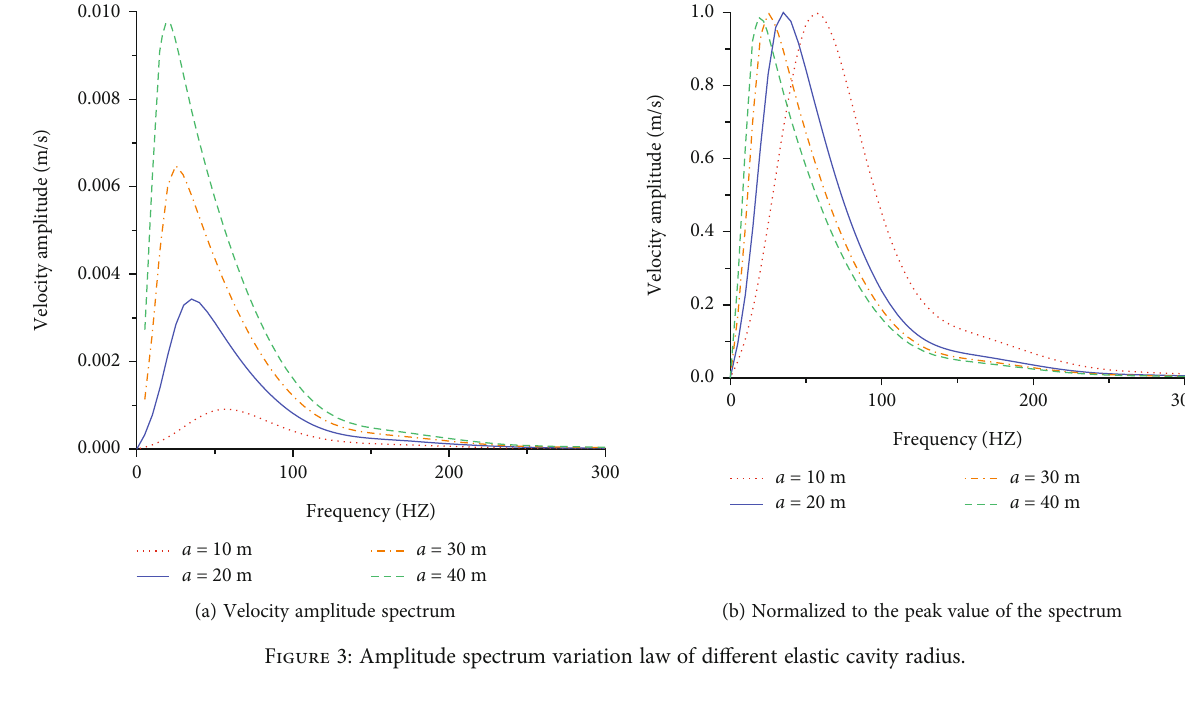
Figure 3: Amplitude spectrum variation law of di ff erent elastic cavity radius.